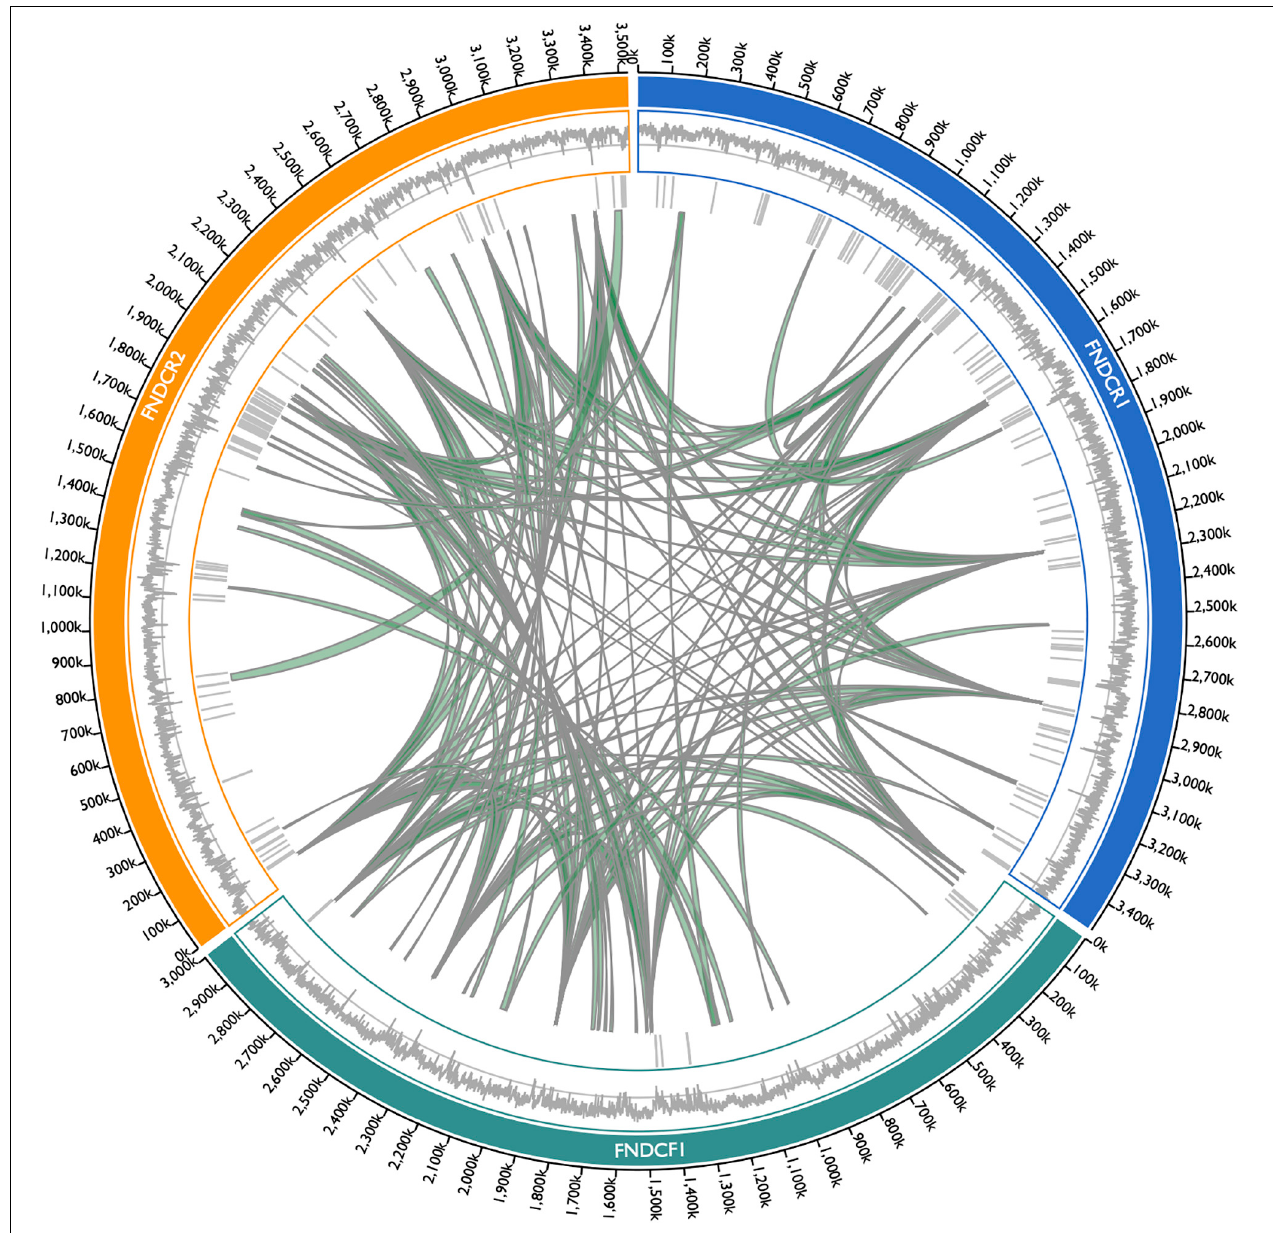
FIGURE 6 | Synteny blocks among the present strain chromosomes. Synteny blocks > 5,000 bp within/among chromosome genomes of FNDCR1 (cyan), FNDCF1 (light green), and FNDCR2 (orange) are shown as gray-colored paths. Synteny blocks were detected using Siberia. The barcode plot outside the synteny block shows where the MGEs are located in the genome. The outer line plot shows the GC content in the genome. The middle line shows the 50% GC content. Numbers on the outside represent the chromosome